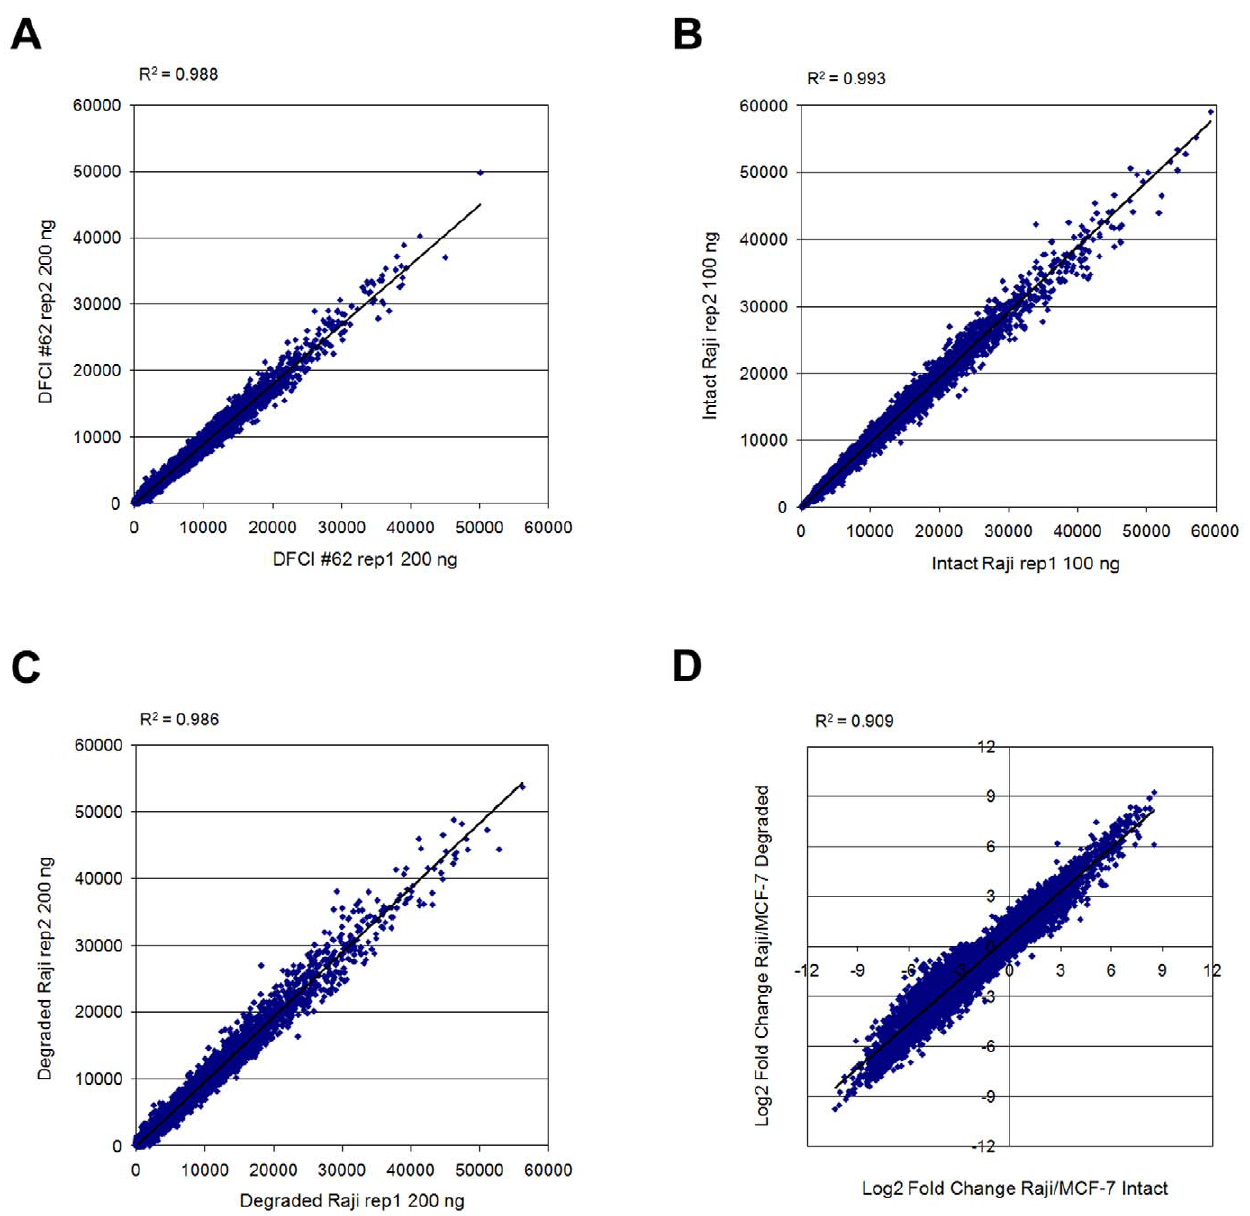
Figure 1. WG-DASL assay reproducibility with variable RNA inputs. Raw intensity scatterplots (all 24526 probes) are shown for WG-DASL assay replicates (replicate 1, x-axis; replicate 2, y-axis) for (A) 200 ng total RNA derived from a formalin-fixed, paraffin-embedded (FFPE) ovarian tumor; (B) 100 ng intact Raji RNA; and (C) 200 ng artificially degraded Raji RNA; (D) The fold-change correlation between intact (x-axis) and artificially degraded (y-axis) cell line RNAs was calculated as the Log 2 of the fold-change between the Raji and MCF-7 sample intensities. All detected probes (Detection p-value , 0.01) are plotted.